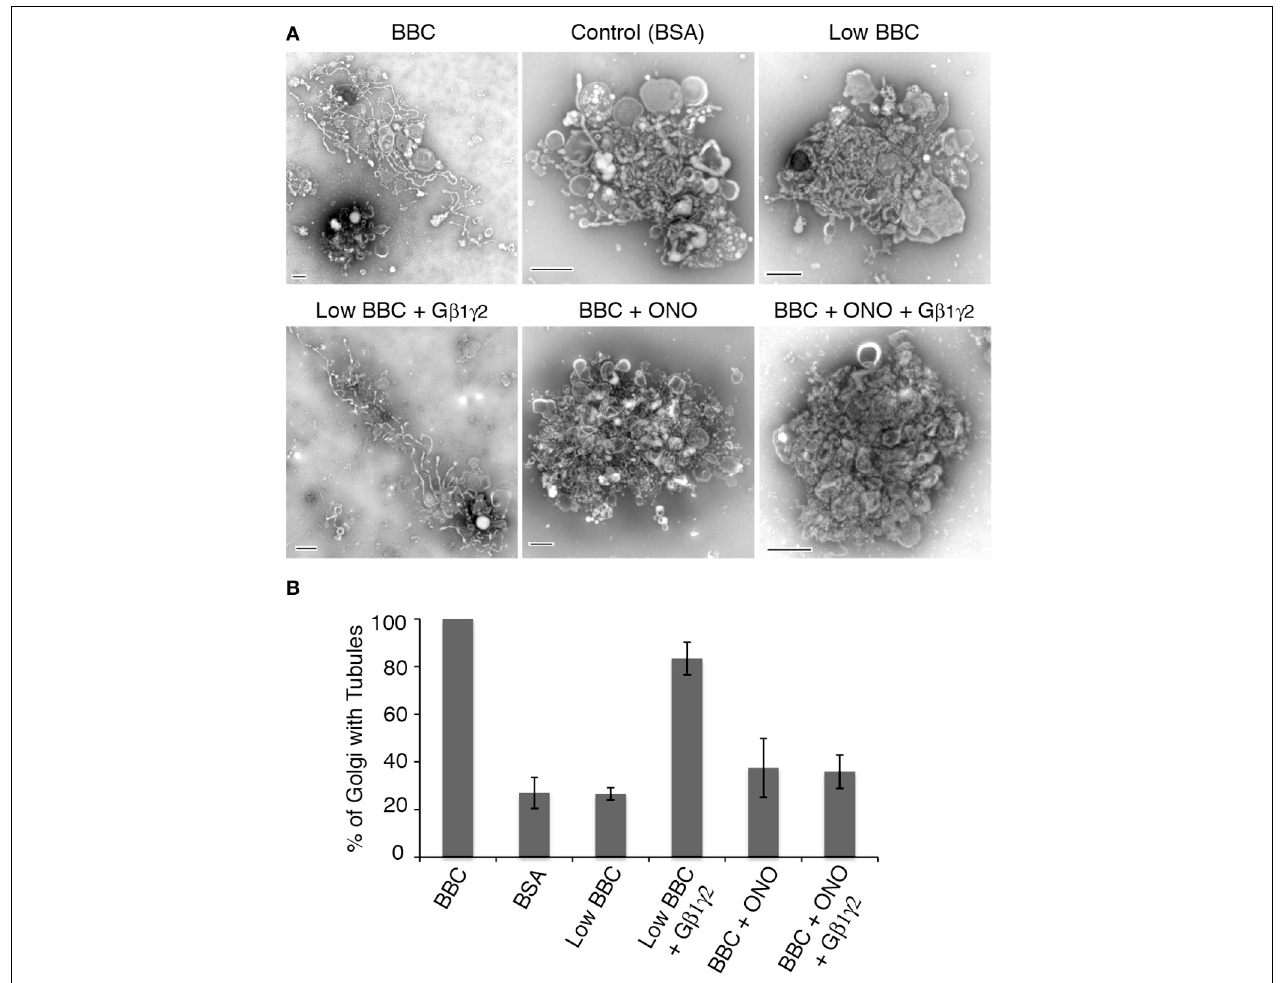
control, was at a final 1mg/ml concentration. ( A ) Representative negative stain Golgi treated with ONO and G β 1 γ 2 as labeled. Scale bars = 500nm. ( B ) Quantification of the percent of Golgi with membrane tubules, normalized to BBC alone (1.5mg/ml). Error bars = s.e.m. Golgi samples with ONO-treated BBC, BSA, or Low BBC were statistically different from Low BBC + G β 1 γ 2 with p -values < 0.013, as determined using